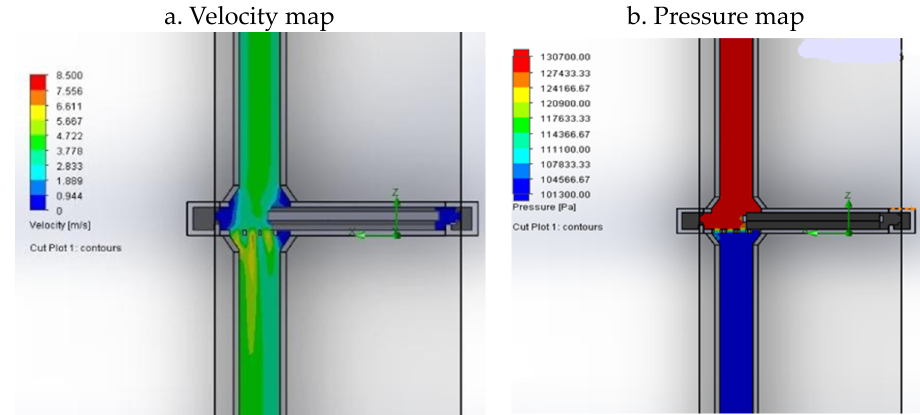
Figure 19. Third valve geometry with 50% opening.